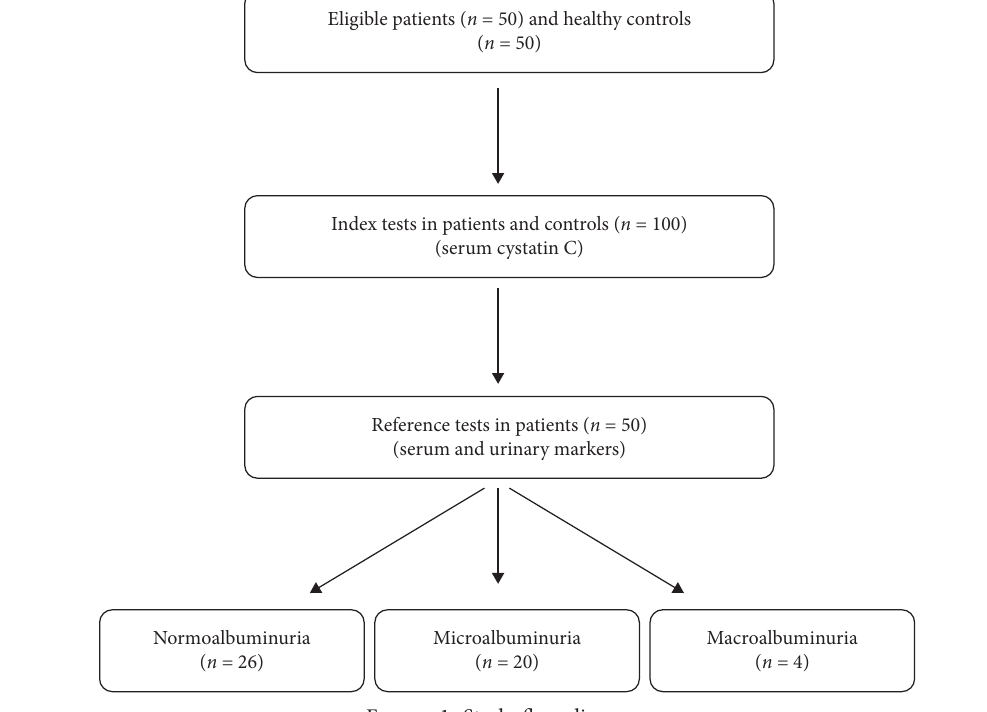
Figure 1: Study flow diagram. Table 1: General characteristics in the T2DM